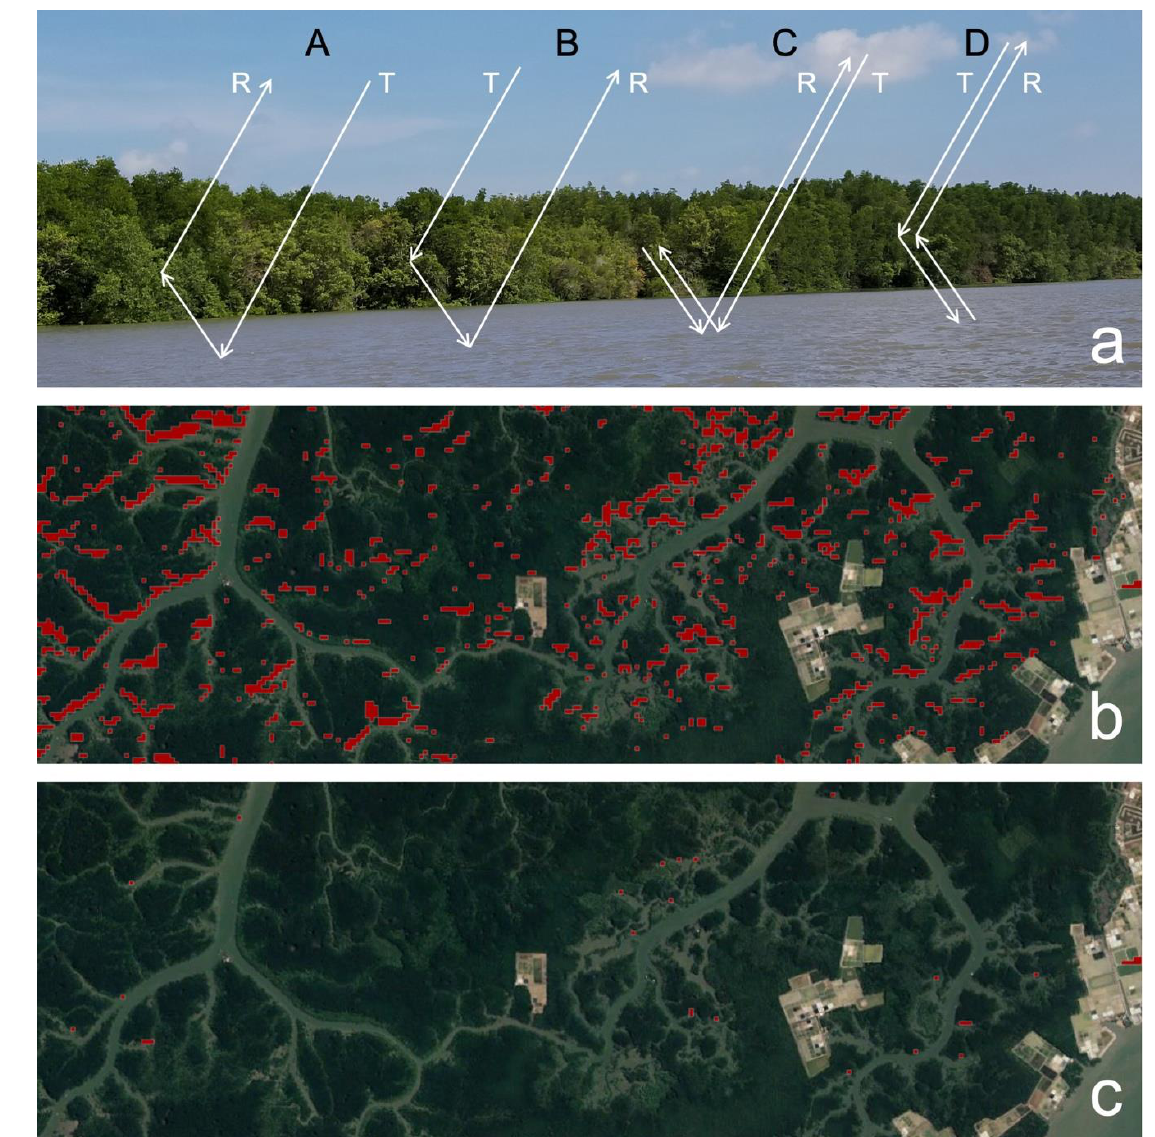
Figure 4. Effects of water-tree interactions on radar scattering mechanisms. Panel ( a ) illustrates water-tree radar interactions using a photograph taken on 20 May 2018 at 10°29′17.37″ N and 106°49′41.76″ E in the Cần Giờ Biosphere Reserve, a UNESCO wetland about 40 km southeast of Hồ Chí Minh City. Panel ( b ) shows misclassified buildings (red pixels) that were mostly removed as seen in Panel ( c ) after the corrections using Sentinel-2 MSI NDVI. Cần Giờ was the worst place for water-tree effects to test the efficacy of the correction method, where misclassification occurred all over the place as in Panel ( b ).